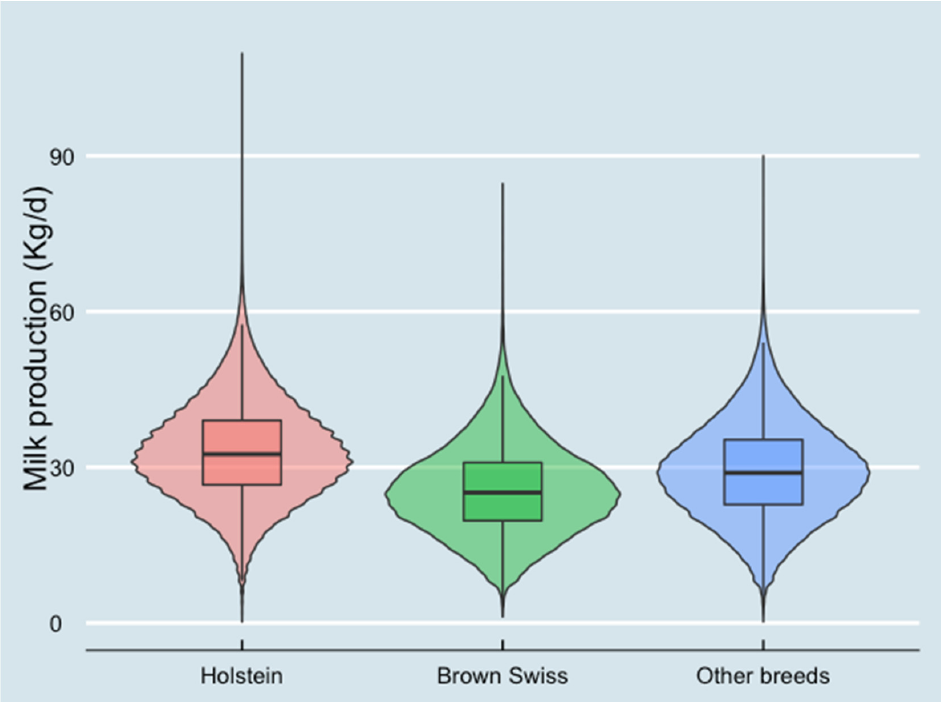
Figure 2. Milk production at test-day records level in different breed groups (10,445,464 test-day records from 826,831 cows in 2970 herds). The violin plot combines the probability density (area under the curve) and box plots.